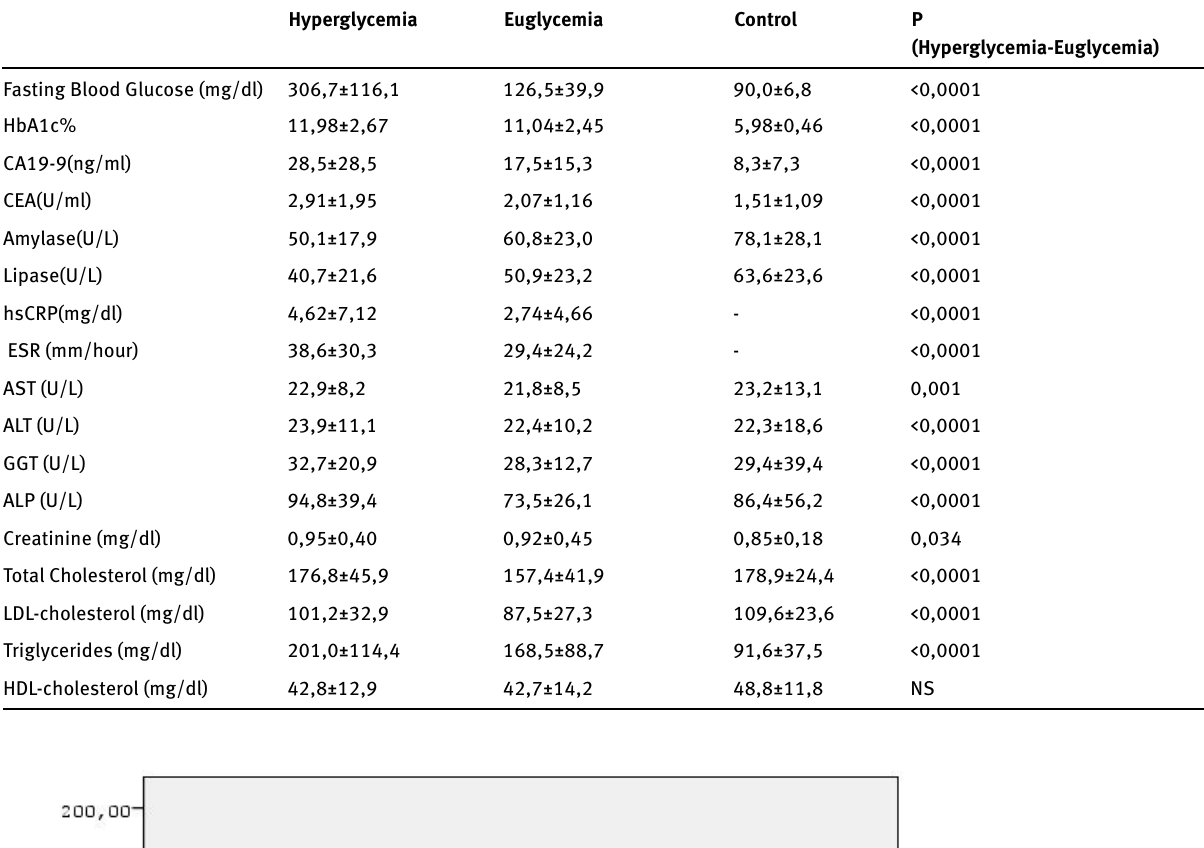
Table 1: Comparison of laboratory characteristics before and after euglycemia was achieved (Mean ± SD).